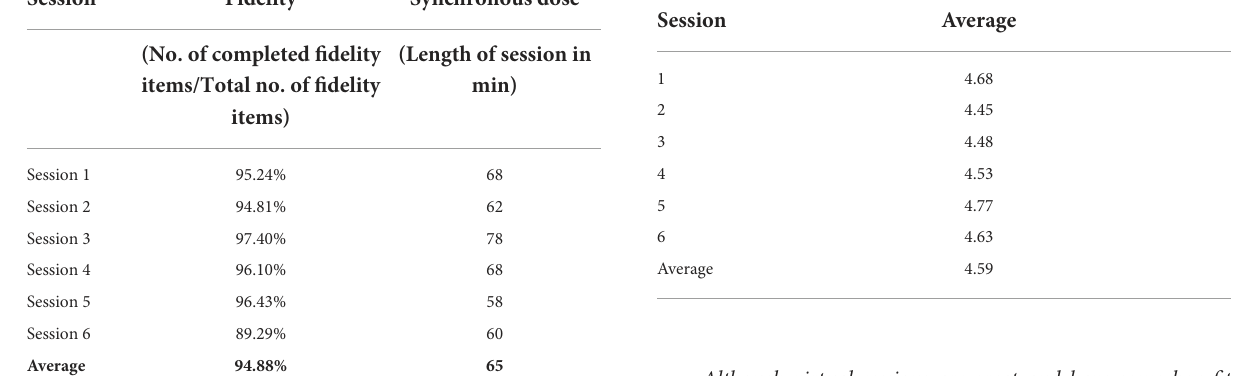
TABLE 6 Summary of iROLL-o’s post-session participant satisfaction (on scale of 1–5: 1 = poor; 5 =